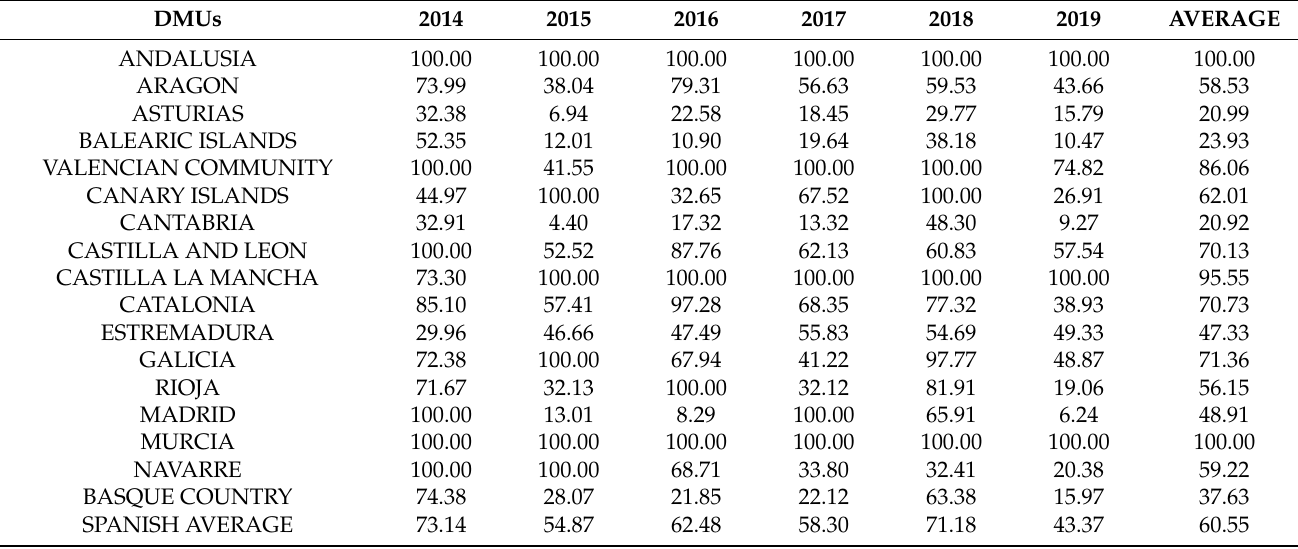
Table 6. Relative efficiency by regions for the period of 2014–2019 (Source: Own elaboration). DMUs